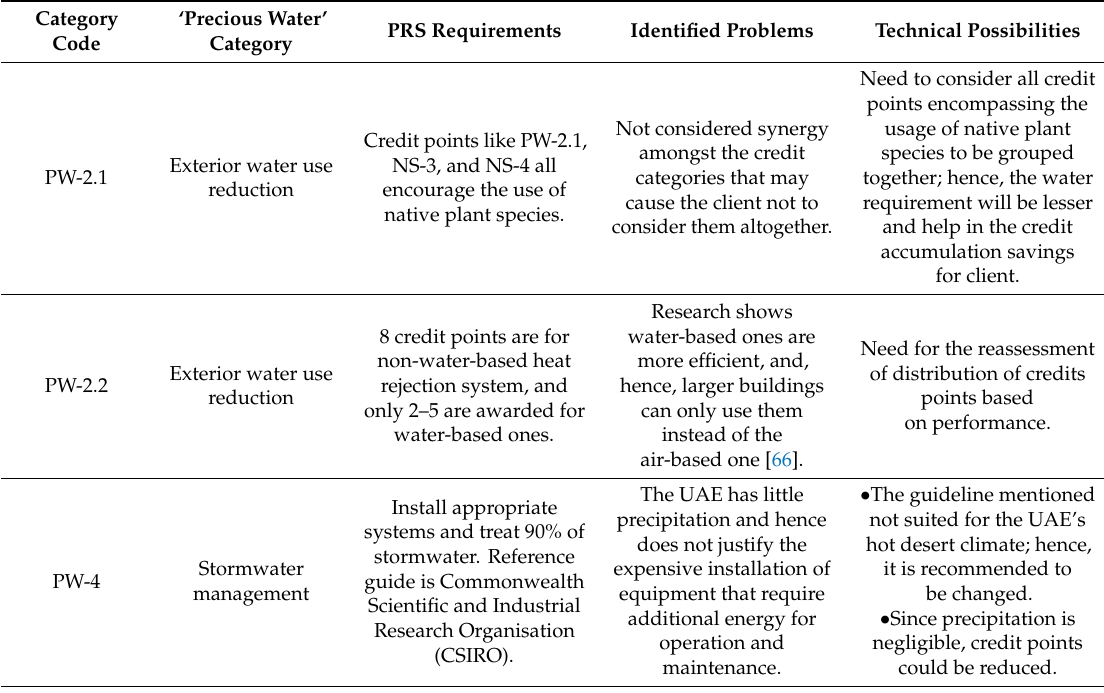
Table 4. Summary of the “Precious Water” (PW) category of the Pearl Rating System with identified problems from the nexus